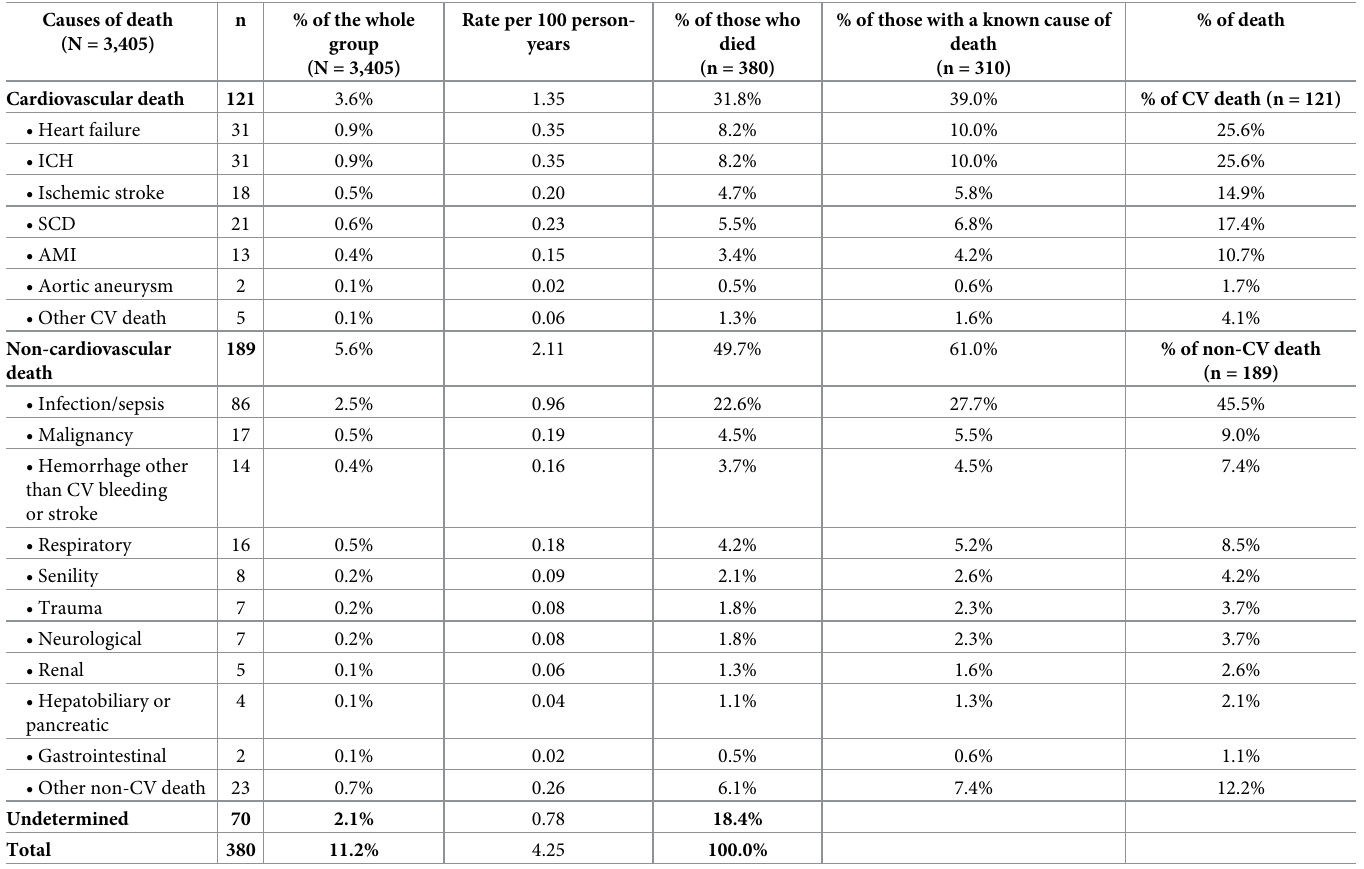
Table 2. The causes of cardiovascular or non-cardiovascular death among the patients enrolled in this